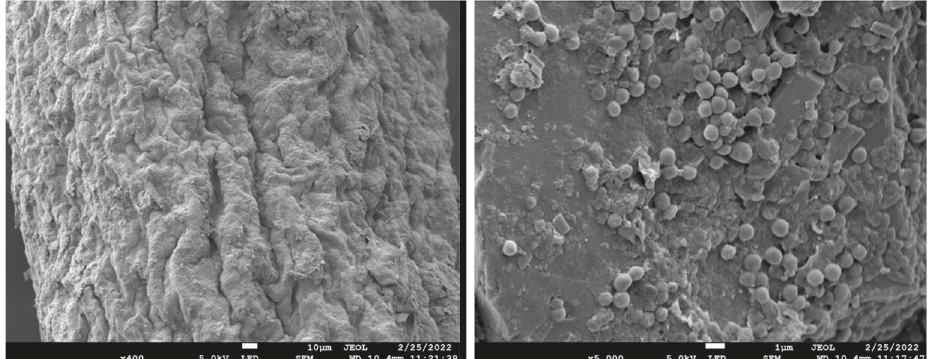
Figure 5: Scanning electron microscopy (SEM) images of Eucheuma cottoni at 10 μ m and 1 μ m.